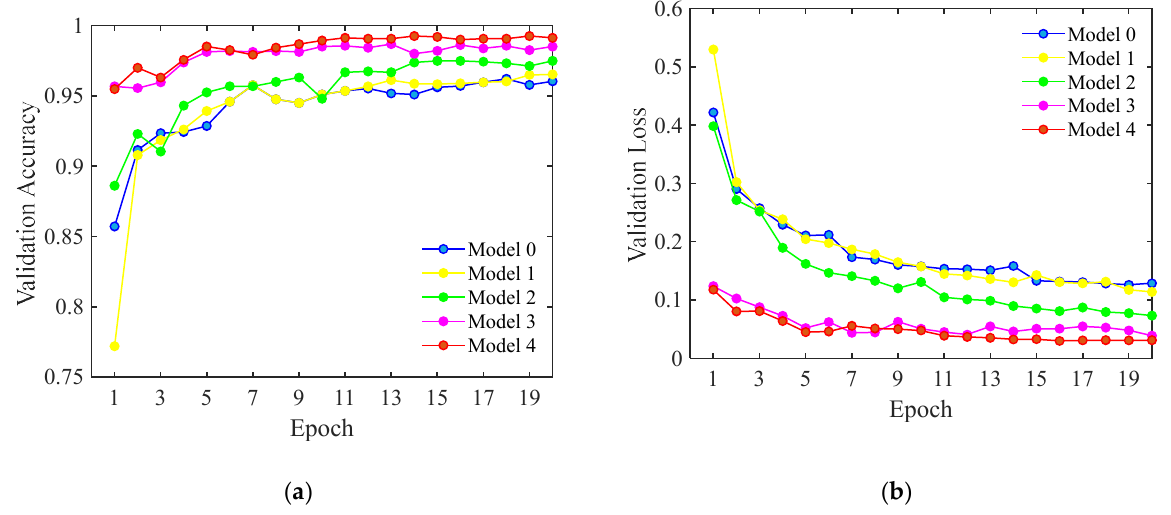
Figure 8. The validation ( a ) accuracies and ( b ) losses of different models.